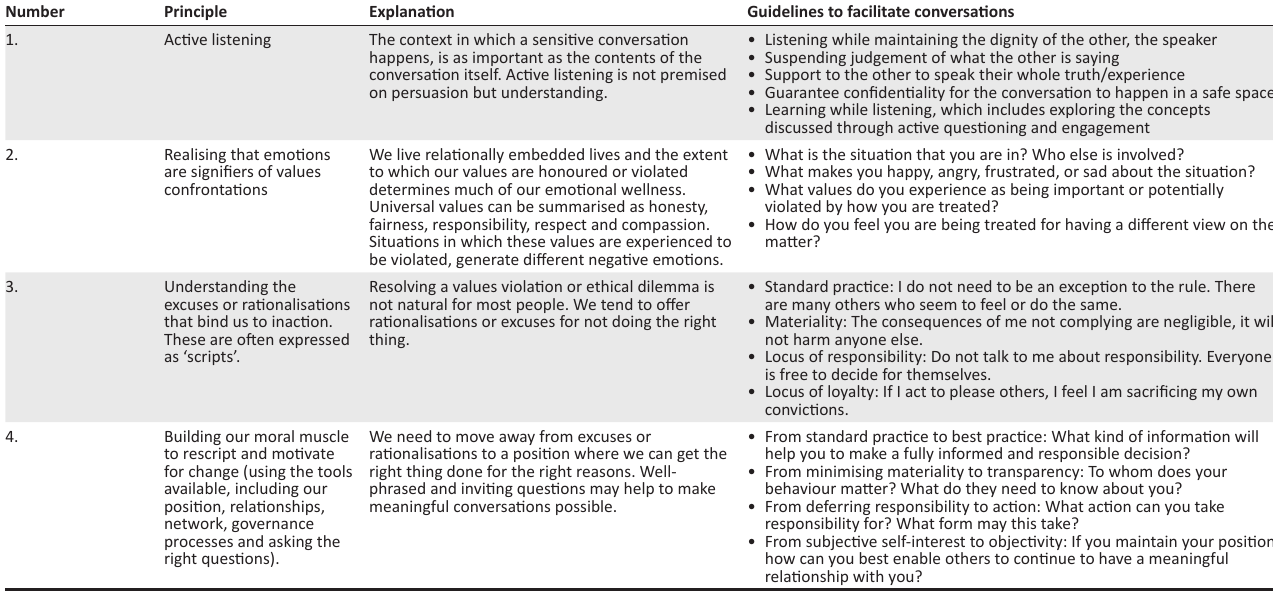
TABLE 1: Principles of a values-driven approach to difficult